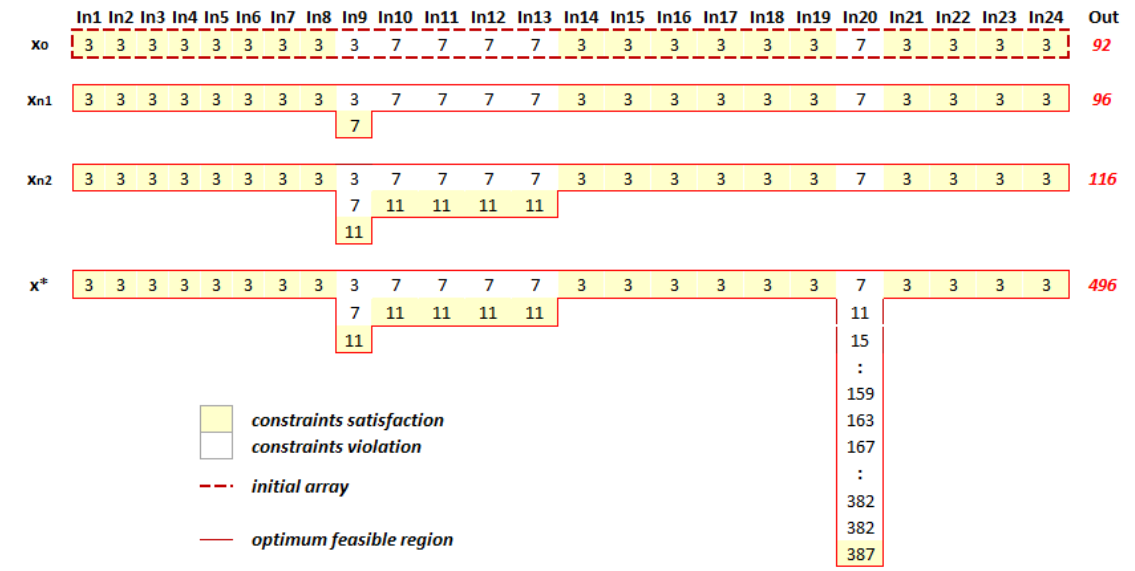
Figure 3. The proposed feed-forward neural network.